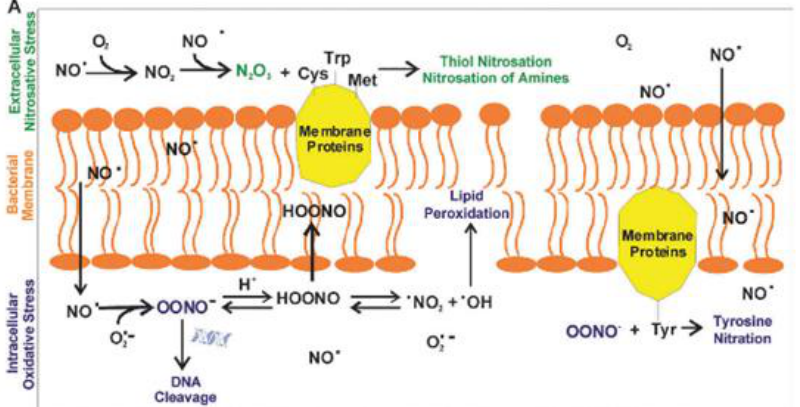
Figure 4. Antimicrobial mechanisms of NO and its byproducts. Reproduced with permission from reference [66]. Copyright 2012 RSC.